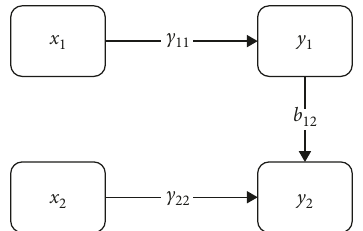
Figure 3: Identified SEM where each exogenous variable directly affects only one endogenous